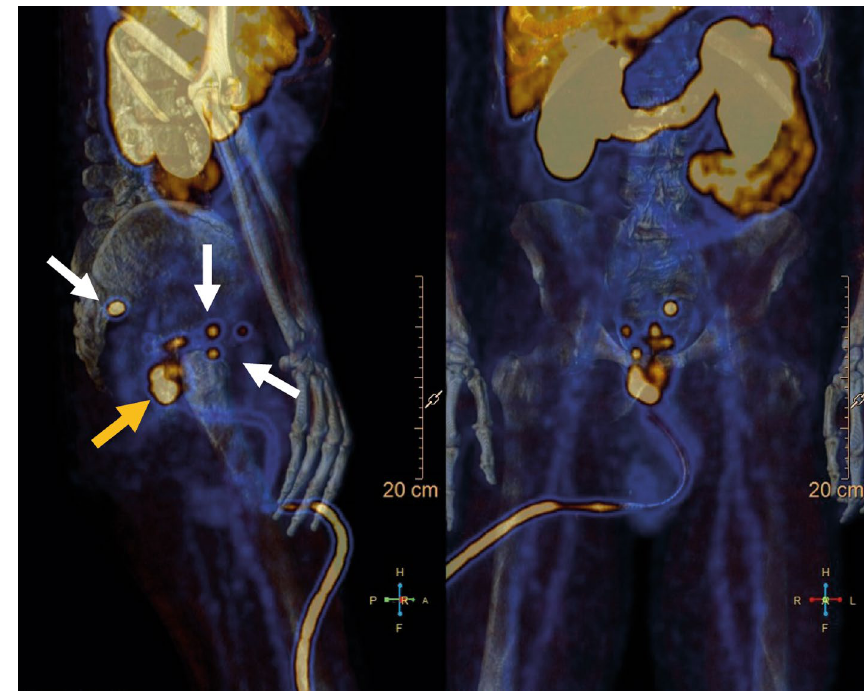
Fig. 2 Patient 01 pre-surgery PSMA PET/CT: the white arrows represent the pelvic lymph nodes; the yellow arrow represents the prostate lesion